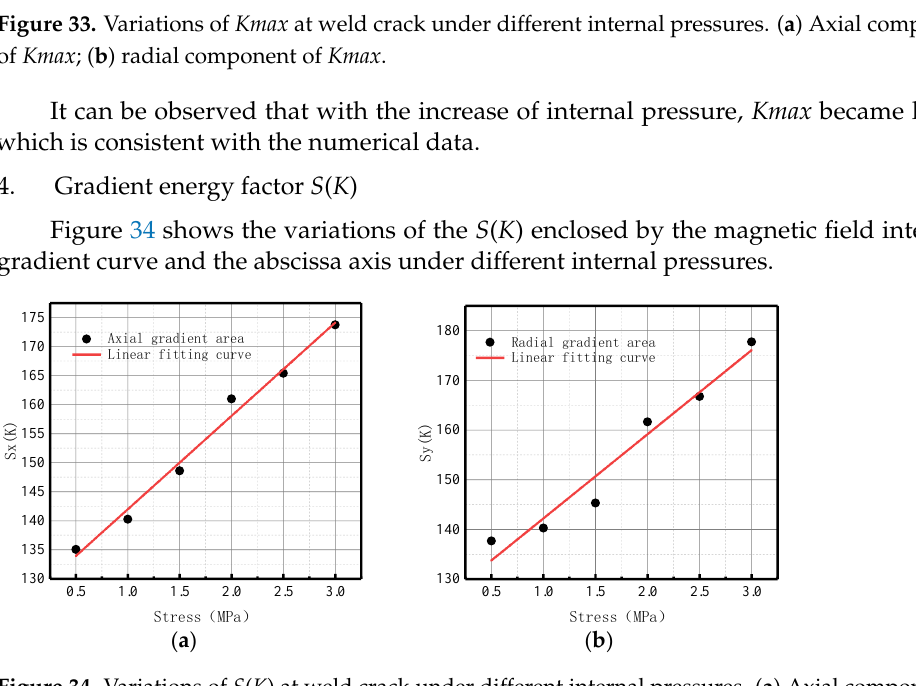
Figure 34. Variations of S ( K ) at weld crack under different internal pressures. ( a ) Axial component of S ( k ); ( b ) radial component of S ( k ).